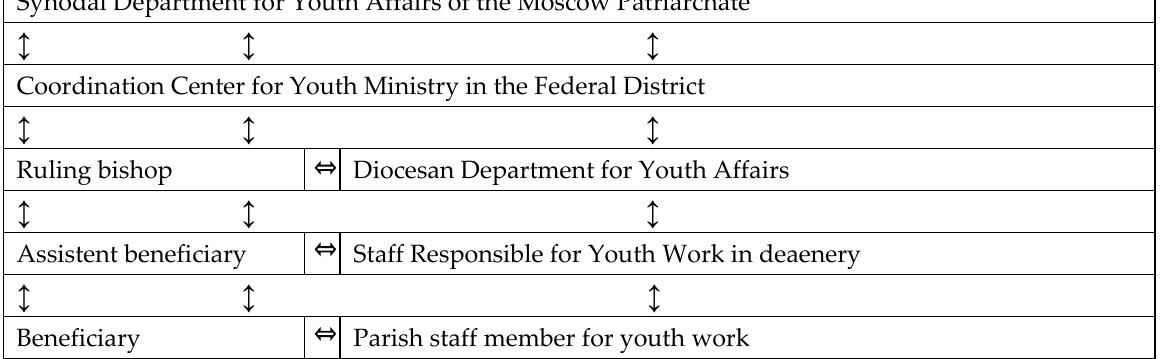
Figure 1. Organization of work with youth in the Russian Orthodox Church.